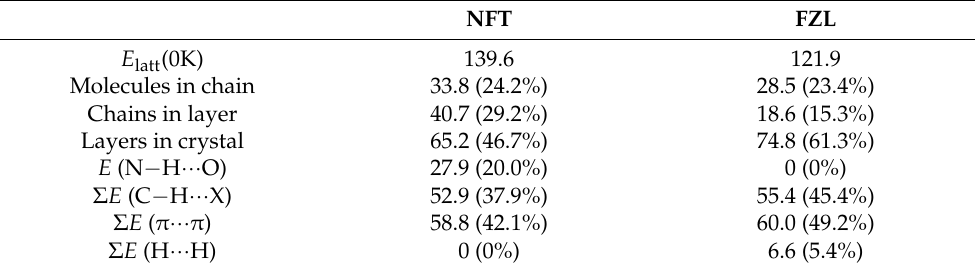
Table 2. Contributions of different types of stabilizing non-covalent interactions into the lattice energy of NFT and FZL in kJ · mol − 1 and % of the E latt (0K) value (in brackets). NFT FZL E latt (0K) 139.6 121.9 Molecules in chain 33.8 (24.2%) Chains in layer Layers in